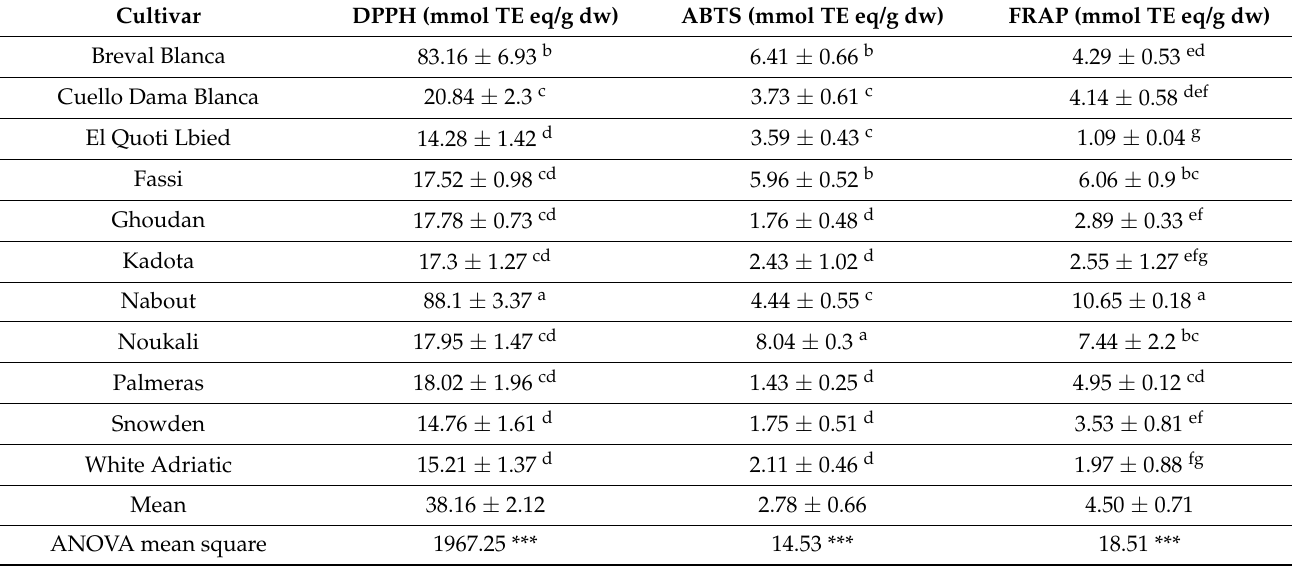
Average values ± standard errors of the mean are presented. Different letters (a–g) in columns represent statistically significant differences among cultivars at p < 0.05. *** denotes significant difference at p <